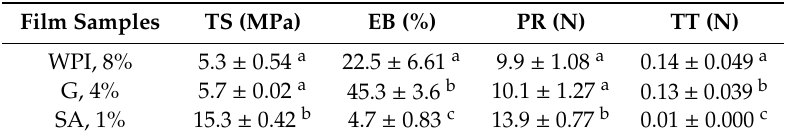
Table 3. Mechanical properties of edible films formed from single ingredients [16] a .